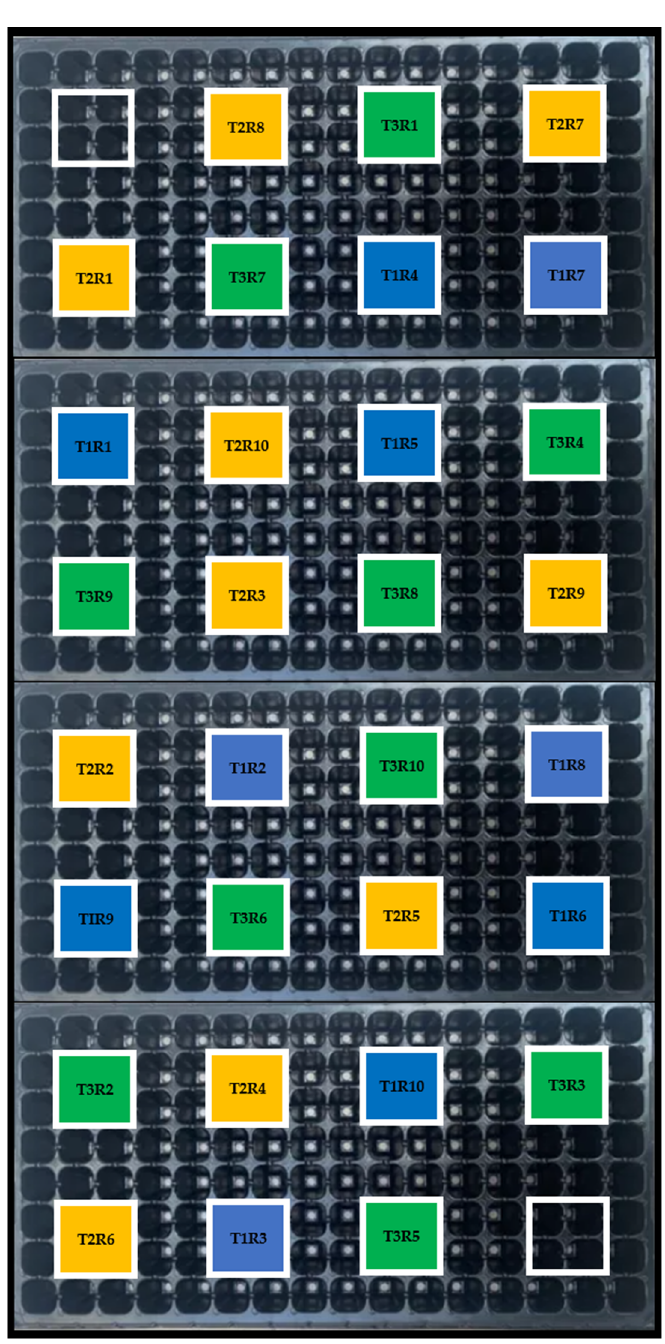
Figure 1. Randomized distribution of treatments and repetitions in the experiment designed to test the effect of different peatmoss/compost combinations on growth and macronutrient concentrations of lulo ( Solanum quitoense Lam.) seedlings under greenhouse conditions. Treatments are as follows (percentage of peatmoss/compost, v / v ): T1: 60/40; T2: 40/60; T3: 20/80. Colors of the boxes within the tray represent the three different treatments tested: Blue for T1; Yellow for T2; and Green for T3. The treatments consisted of different combinations of peatmoss and composted sugarcane filter cake (in percentage, v / v ): treatment 1 (T1): 60/40 (peatmoss/compost); treatment 2 (T2): 40/60 (peatmoss/compost); and treatment 3 (T3): 20/80 (peatmoss/compost). The nutrient concentrations of these substrates are shown in Table 1, while the physical and chemical properties are displayed in Table 2.